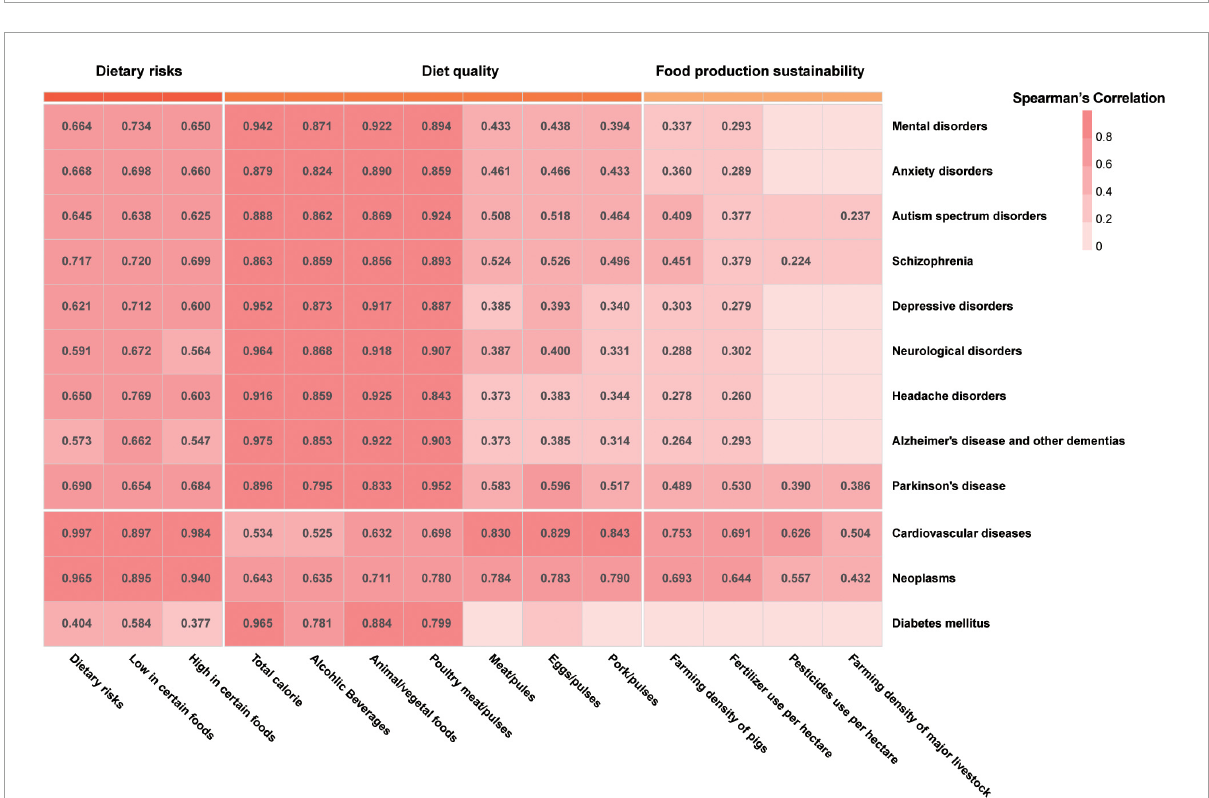
FIGURE11 The correlation between disease burdens and diet quality and food production sustainability. Only the correlation coefficients with adjusted p -value of below 0.05 were shown in the figure.